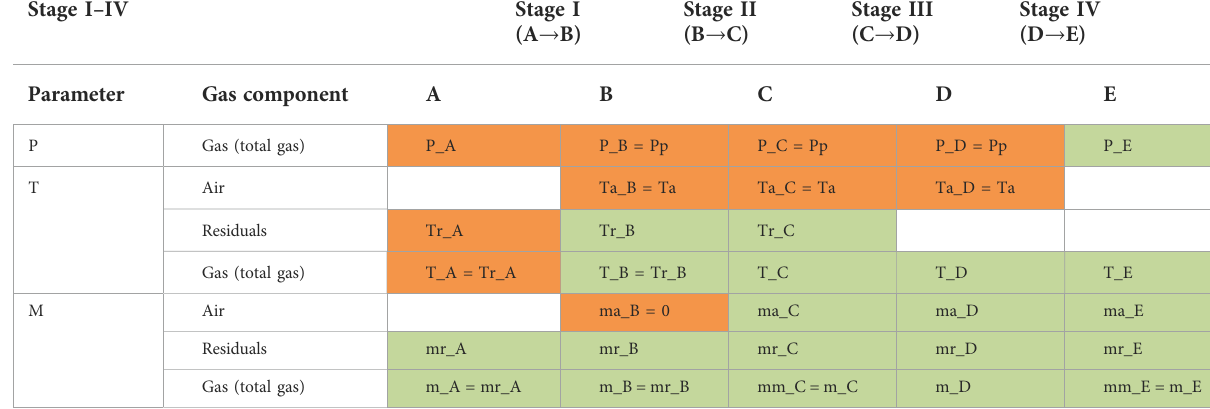
TABLE 1 Key parameters of the ZDMS